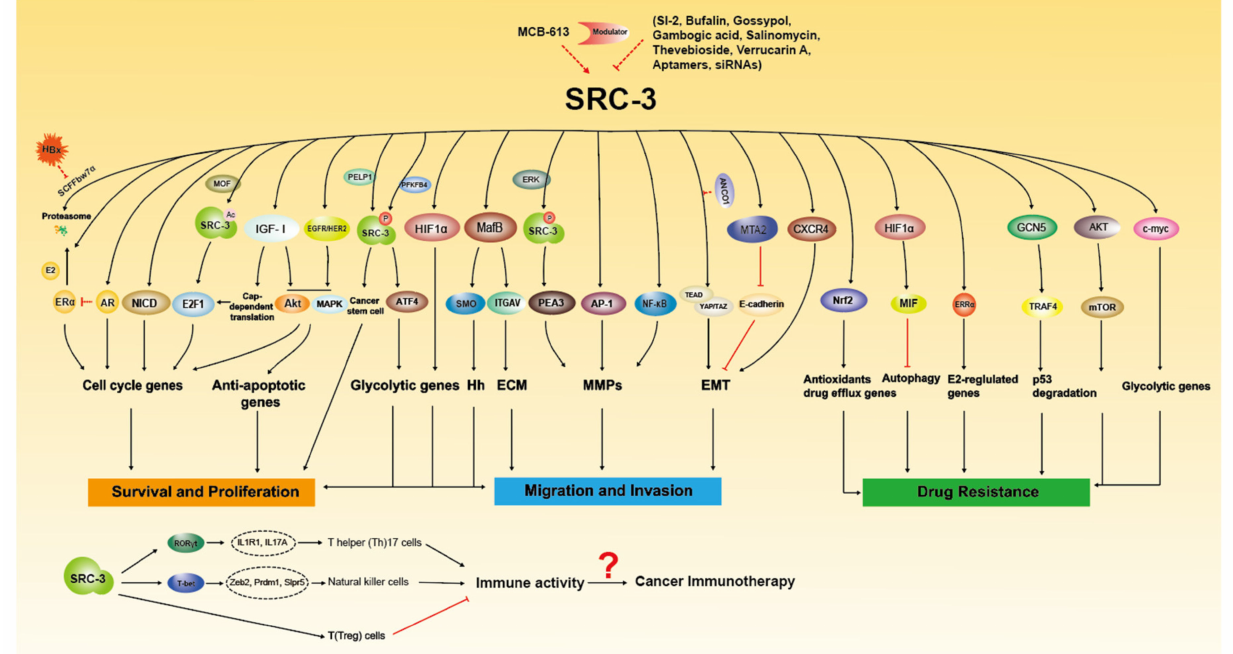
Figure 2. The molecular functions of SRC-3 in Tumorigenesis. SRC-3 promotes cancer growth, metastasis and drug resistance through multiple signaling pathways. SRC-3 modulators have been developed to regulate the expression and activity of SRC-3. SRC-3 affects the development of immune cells to regulate immune response, which suggest that SRC-3 may play certain role in cancer